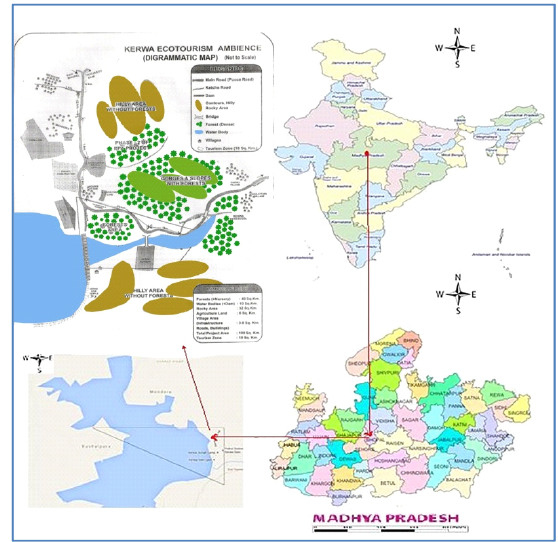
Fig. 1: Kerwa ecotourism ambience